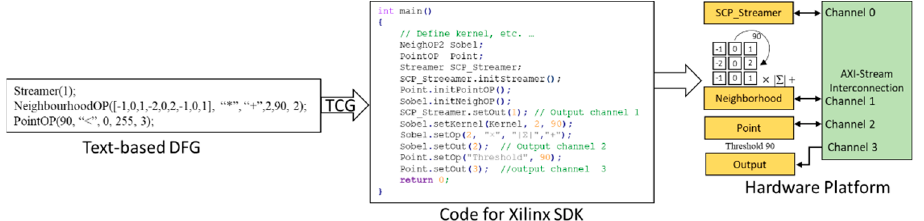
Figure 7. From text-based DFG to hardware platform through Xilinx SDK.